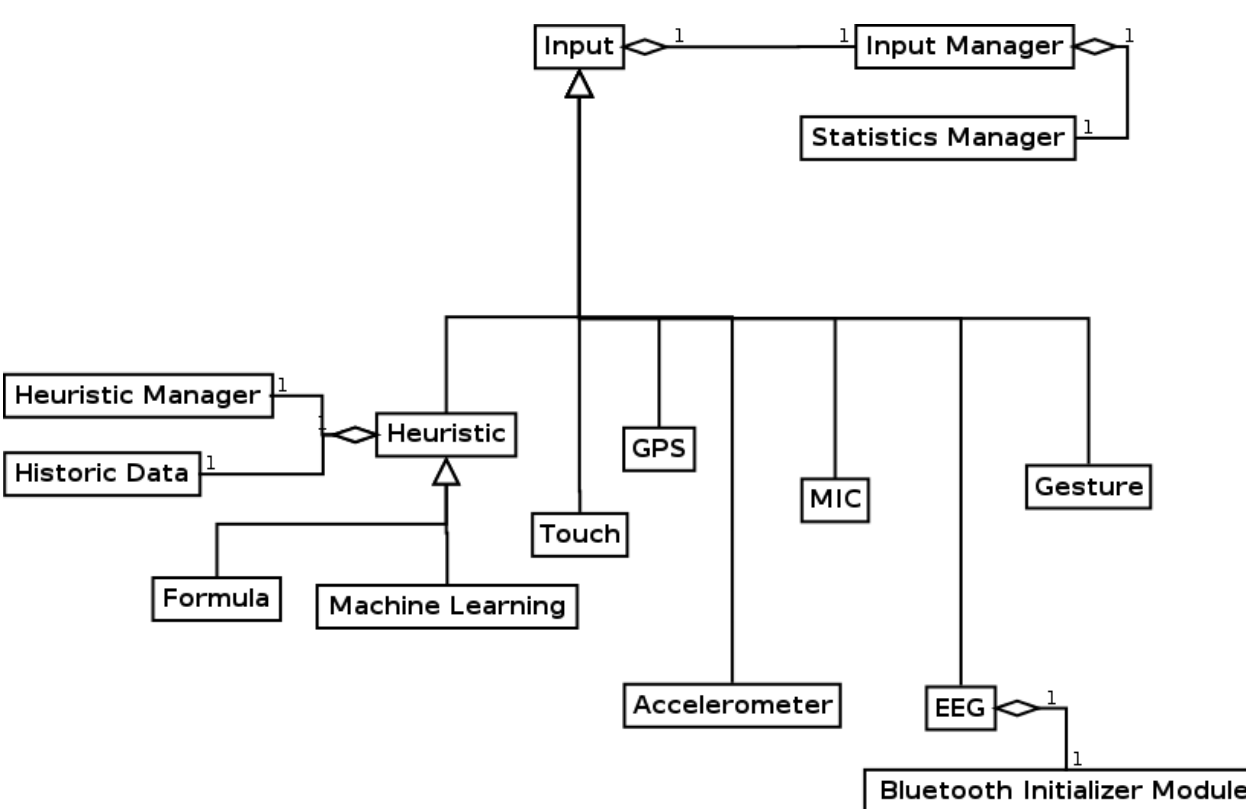
Figure 2: UML of the Input and Heuristics